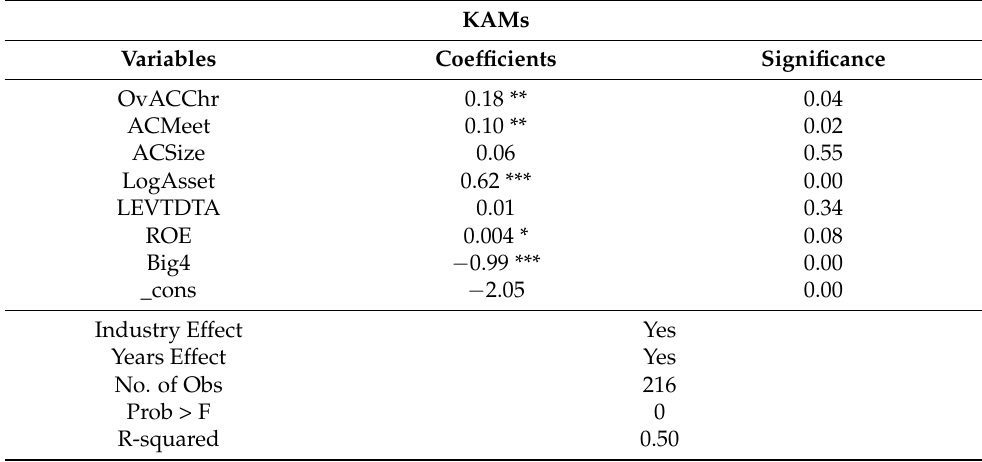
Table 4. Impact of OvACChr on KAMs.